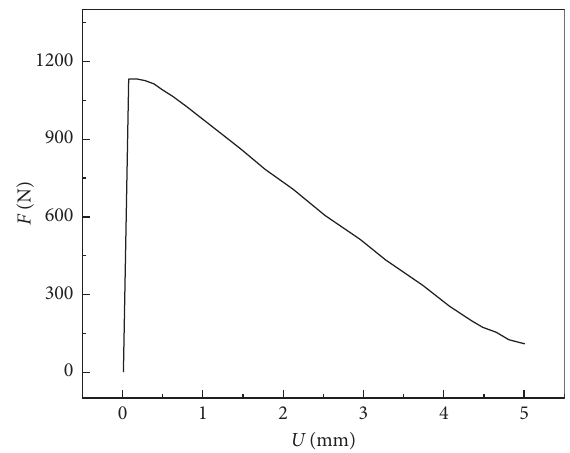
Figure 17: Variation of pull-out force against pull-out